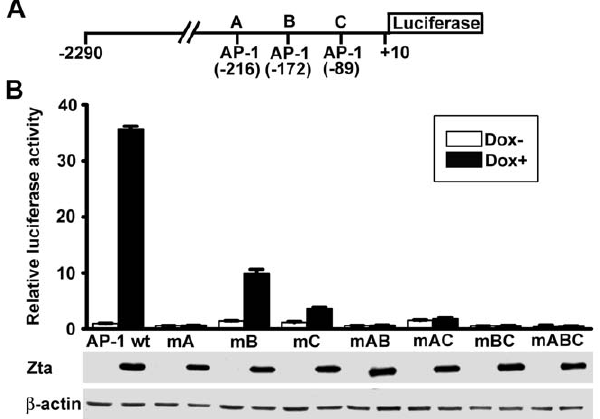
Figure 4. Zta-induced activation of the MMP3 promoter requires three AP-1 elements. ( A ) The MMP3 promoter used in the reporter gene assay is illustrated schematically. Three AP-1 elements at 2 216, 2 172, and 2 89 of the promoter are indicated and labeled as A, B, and C, respectively. ( B ) The reporter plasmids driven by the wild- type (wt) MMP3 promoter or its AP-1-mutated derivatives (mA, mB, mC, mAB, mBC, mAC, and mABC) were transfected into HONE-tetonZ cells in the presence (black bars) or absence (white bars) of doxycycline induction. The promoter activity was examined by using a luciferase assay. Expression of Zta and b -actin was examined by an immunoblot- ting assay.